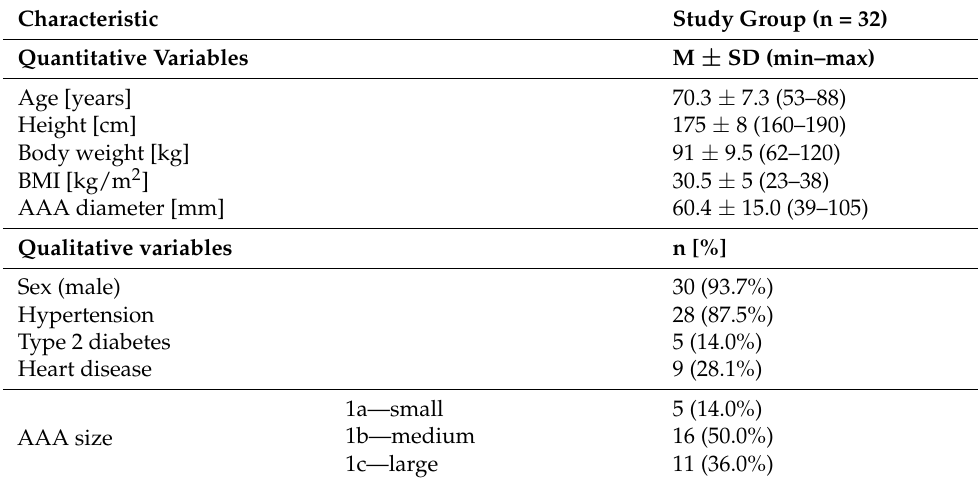
Table 1. Demographic and clinical characteristics of study participants (n =